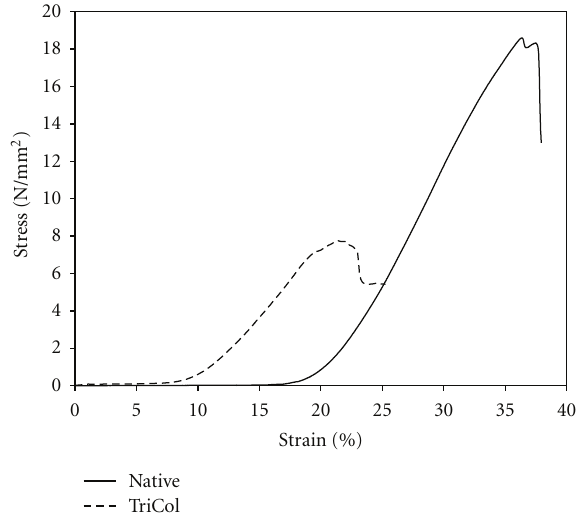
Figure 5: Stress-strain diagram of native and TriCol-decellularized bovine pericardium strips. See Section